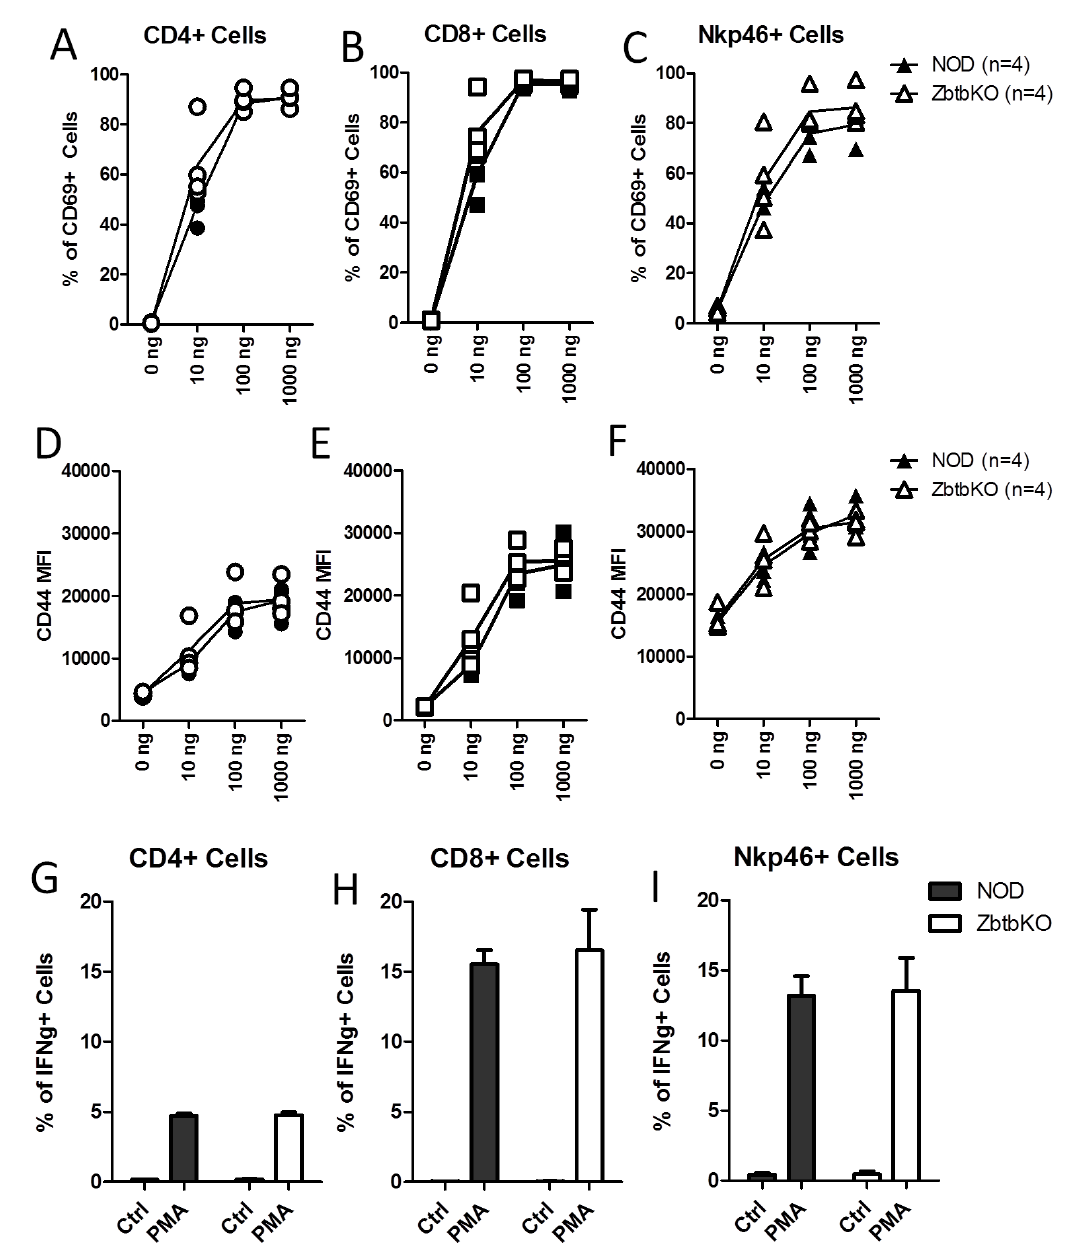
Figure 4. Activation markers and cytokine production in Zbtb32 -/- splenocytes after ex vivo stimulation. Freshly isolated splenocytes from female NOD.Zbtb32 -/- mice and control littermates were stimulated with the indicated dosages of anti-CD3 for 18 h. Surface expression of CD69 ( A – C ) and CD44 ( D – F ) was measured on CD4 + , CD8 + , and NKp46 + splenocytes. For IFN γ staining, splenocytes from female NOD.Zbtb32 -/- mice and their control littermates were stimulated with PMA and Ionomycin for 4 hours ( G – I ). The percentage of cells positive for IFN γ in CD4 + ( G ), CD8 + ( H ), and NKp46 + cells ( I ) is shown. The data were combined from two independent repeats of this experiment.